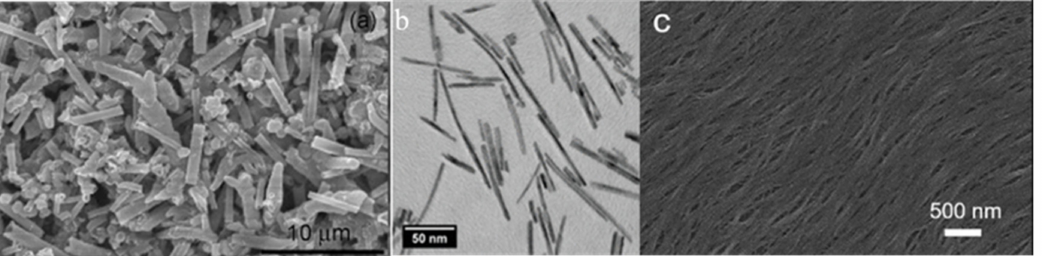
Figure 6. Different one-dimensional tungsten oxide nanostructures: ( a ) nanotubes [73], ( b ) nanorods [74], ( c ) nanowires [75]. Reddy [86] prepared WO 3 fibers with lengths of 50–200 nm and widths of 20–60